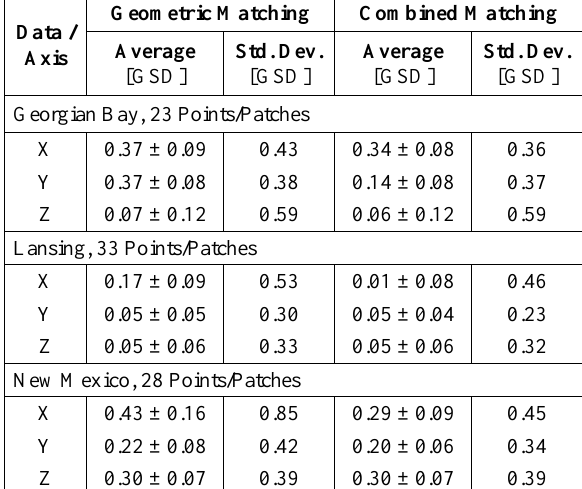
Table 2. Averages and standard deviations of differences be- tween manually measured and automatically computed ADS strip offsets.